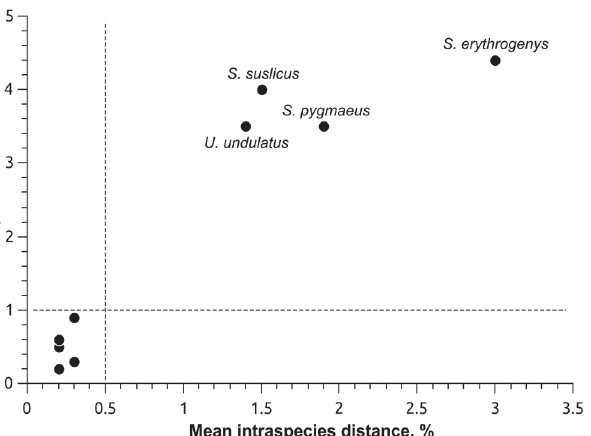
Figure 2. Plot of maximum intraspecies distances against mean intraspecies distances of Eurasian ground squirrels (excluding singletons). Species names are given for putative species complexes indicated by DNA barcoding.